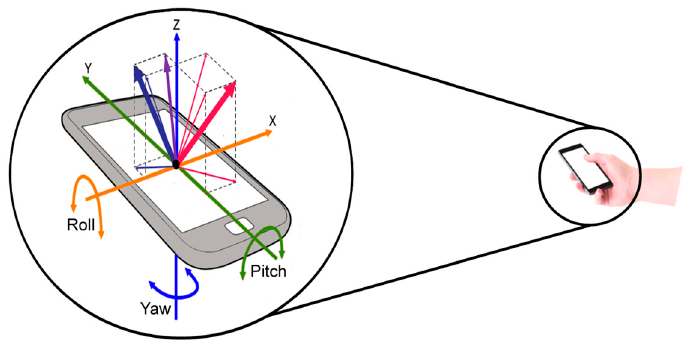
Figure 1. Smartphone inertial sensors are sensitive to the orientation of the smartphone. The accelerometer measures acceleration, the gyroscope measures rotation, and the magnetometer measures the magnetic field strength along the x , y , and z axes.